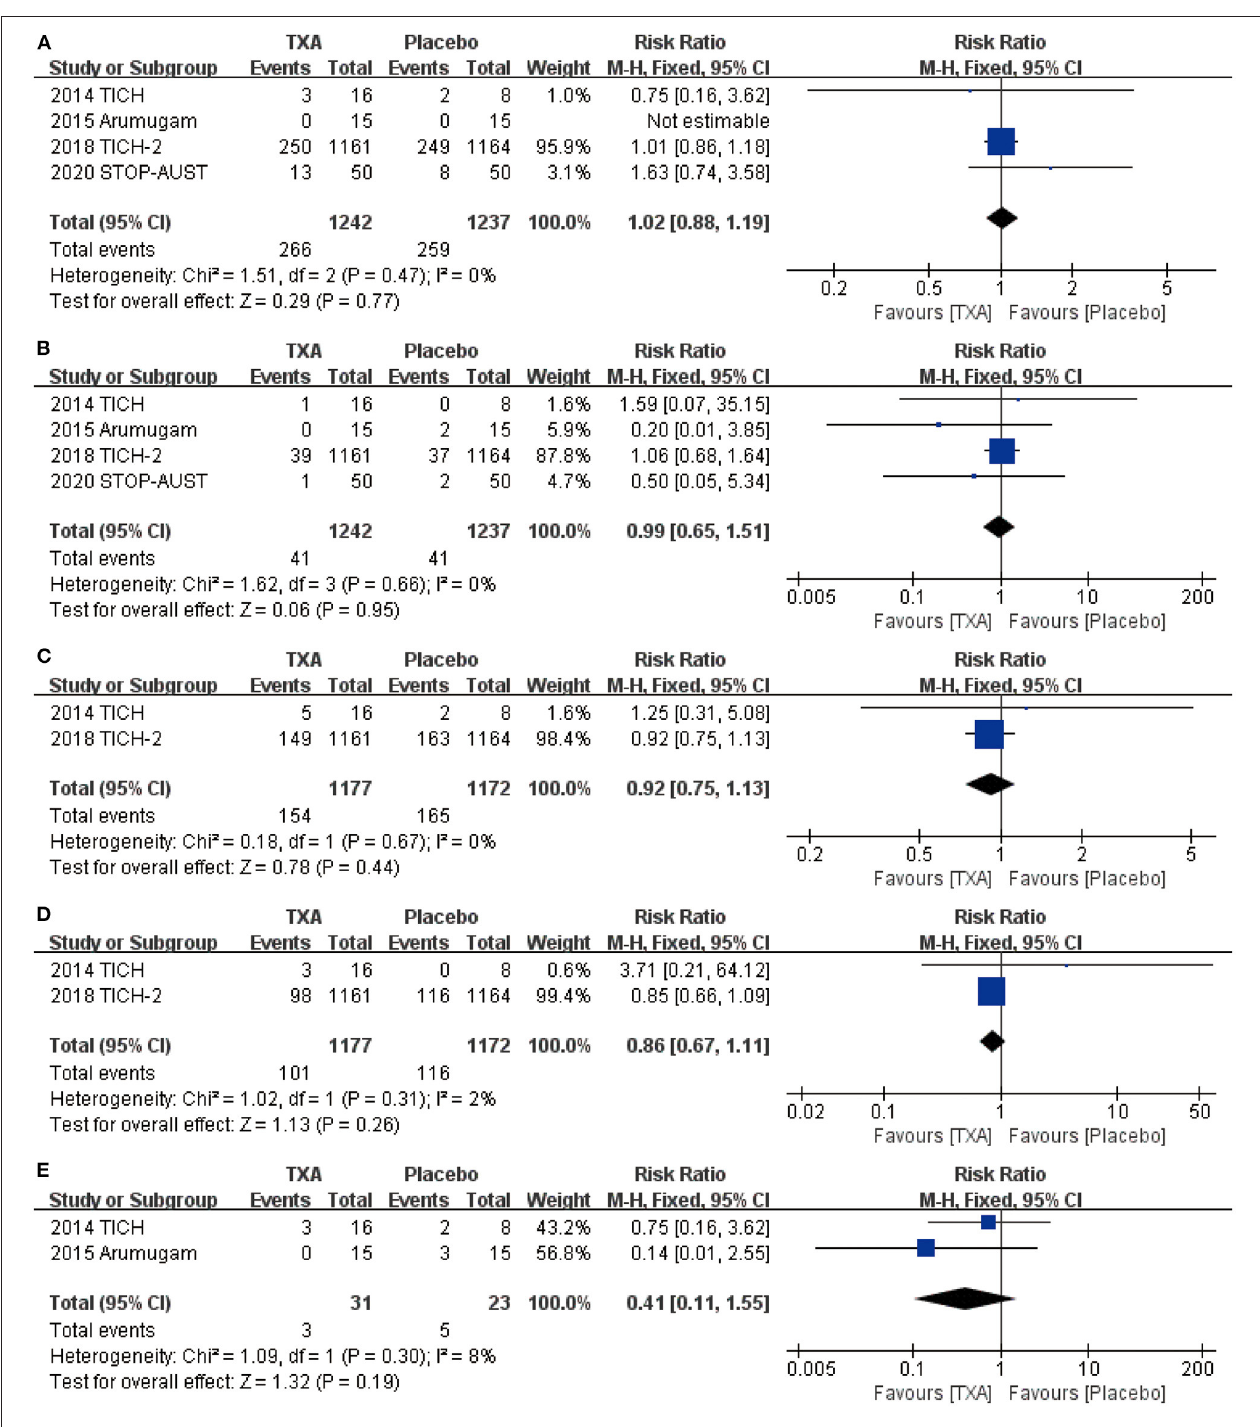
FIGURE 3 | The pooled risk ratio (RR) of safety indicators compared with placebo, the diamond indicates the estimated RR with 95% confidence interval (CI) for the pooled patients. (A) death; (B) . thromboembolic events; (C) neurological deterioration; (D) infection; (E) craniotomy.